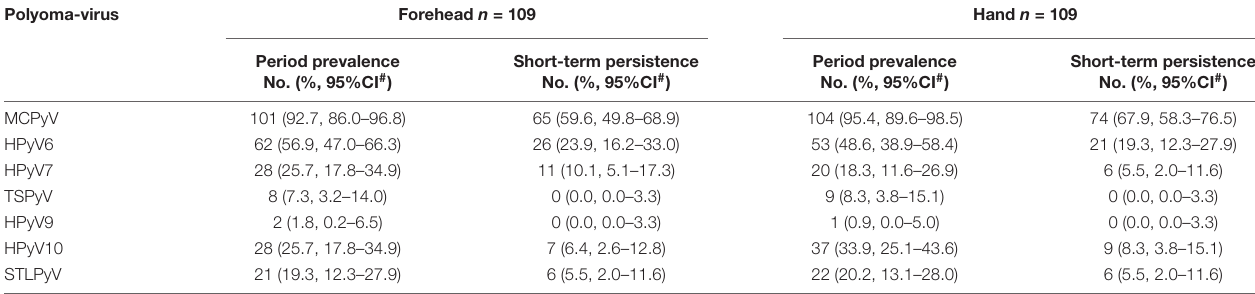
TABLE 3 | Site-specific HPyV period-prevalence and short-term persistence. Polyoma-virus